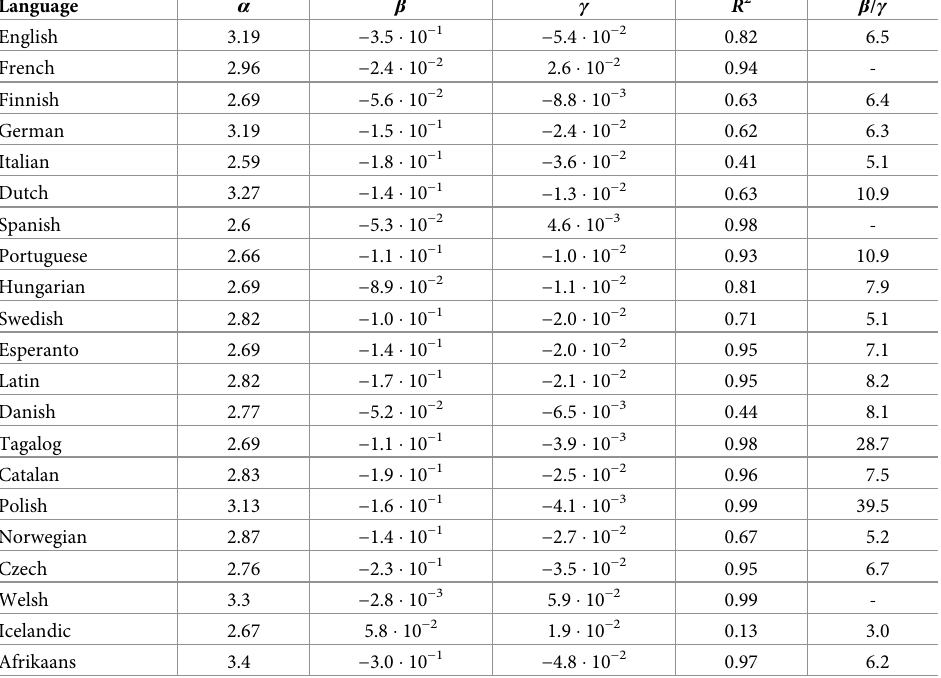
Table 4. The estimated parameters of MAL for the Gutenberg Corpus. Fitting of MAL to the experimental data has been done using Levenberg–Marquardt algorithm and excluding words with only one syllable. R 2 (coefficient of deter- mination) is used to determine the goodness of the fit. Column β / γ corresponds to the observable extremum of MAL for β � γ > 0 or is left blank otherwise.